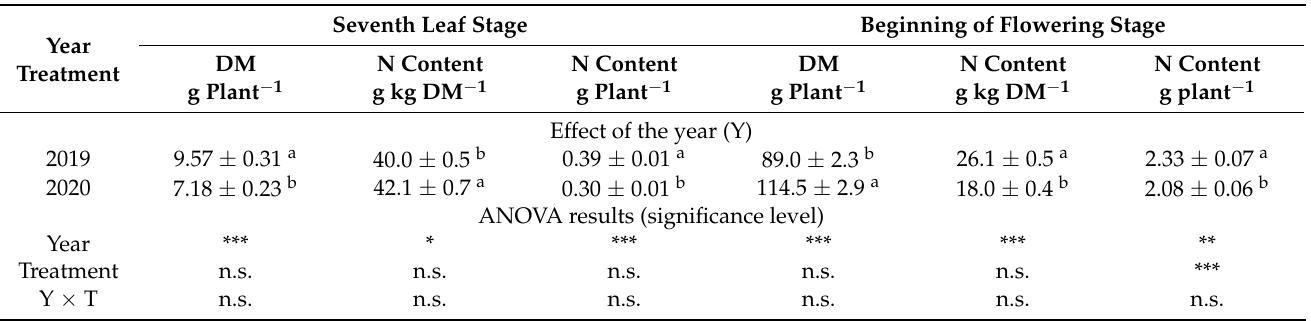
Table 3. Effect of the growing season and fertilization treatments on maize dry matter (DM) and nitrogen (N) status at the seventh leaf stage and at the beginning of flowering.